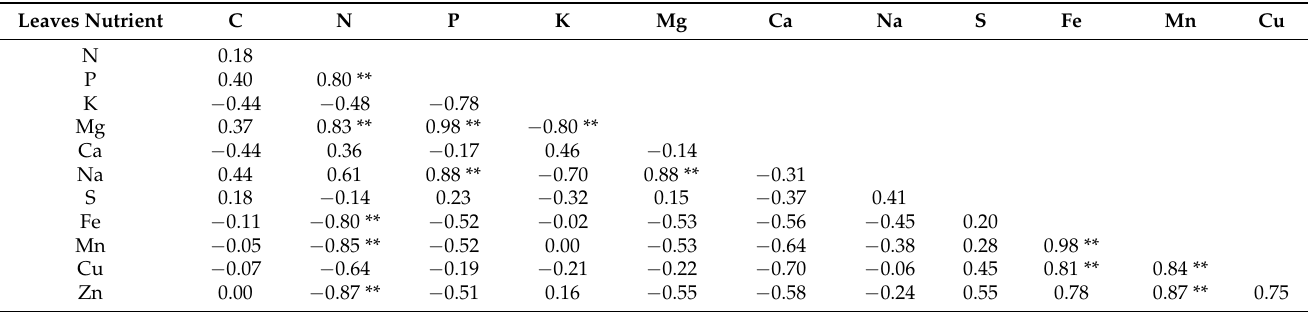
Table 7. Pearson coefficient correlation of macro- and micronutrients status of kaffir lime leaves in four growing locations. Leaves